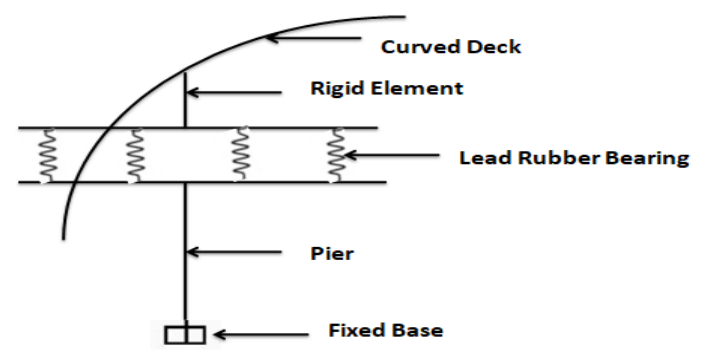
Figure 3. Modeling of isolation bearings, pier, and bridge deck junction .